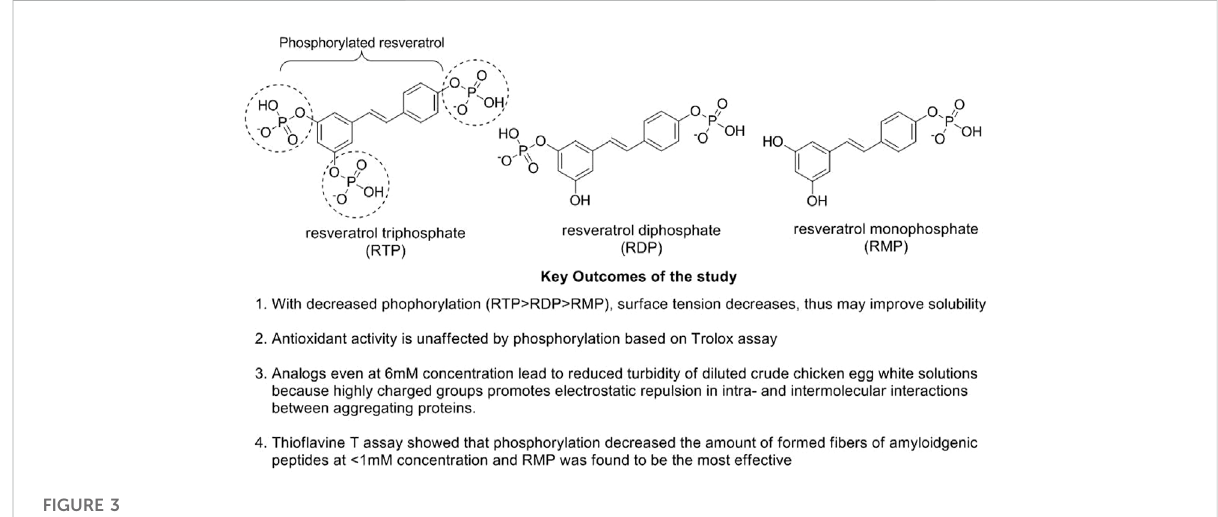
FIGURE 3 Mechanistic study of phosphorylated resveratrol in